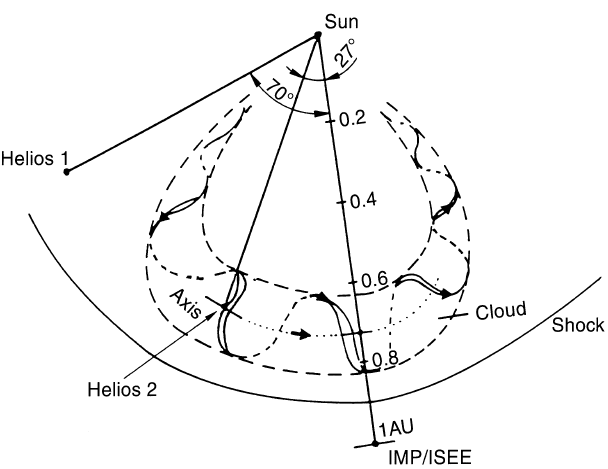
Fig. 11. Sketch showing the possible large-scale geometry of the MC observed by Helios 2 and IMP/ISEE in April 1979 (see Fig. 10) based on results of the MVA of the magnetic field data. Helios 1 did observe the shock, but not the MC. Arrows denote the orientation of the magnetic field lines at the cloud’s outer boundaries and on its axis